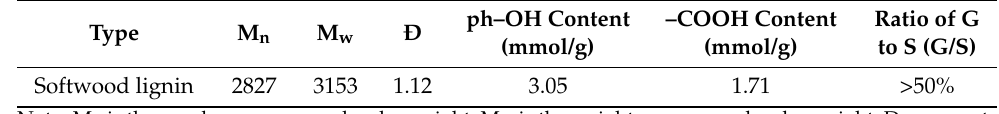
ph–OH Content –COOH Content Ratio of G (mmol/g) (mmol/g) to S (G/S)